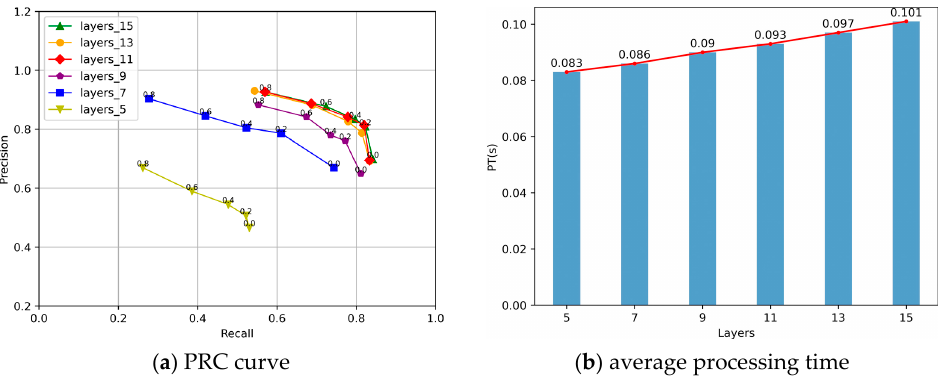
Figure 10. The performance of the algorithm under different network layers.